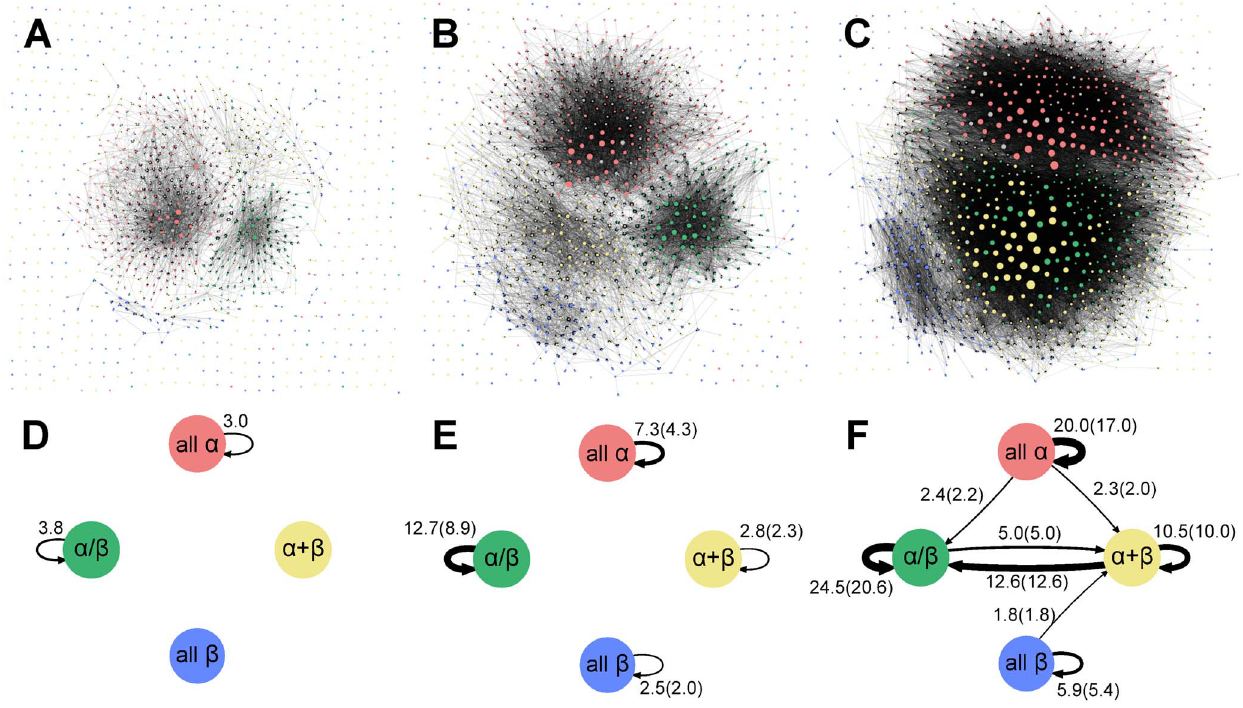
Figure 10. Graphical representation of the protein fold universe. (A)–(C) The detailed graphical representations of the protein fold universe connected by the SQ (A), RW (B), and RR (C) schemes. In these networks, protein folds are represented by nodes and connected by the directed edge. The directed edge between A and B is created from A to B if the TM-score( A ? B ) is larger than 0.5. The node size is proportional to the out-degree of the node. Nodes are colored according to their SCOP class as follows: all- a (red), all- b (blue), a / b (green), a + b (yellow), and others (black). (D)–(F) The simplified networks of the protein fold universe based on the SQ (D), RW (E) and RR (F) networks. Each node represents all- a , all- b , a / b , and a + b classes defined in the SCOP database. The directed edge is drawn if N edge ( A ? B ) is larger than 1.0, where X represents the alignment scheme. The X numerical value of N edge ( A ? B ) is shown near the edge. The numerical values shown in parentheses in Figure 9(E) and (F) are X N edge ( A ? B ) { N edge ( A ? B ) and N edge ( A ? B ) { N edge ( A ? B ) , respectively. The width of the arrows indicates the numerical value of N edge RW RR SQ SQ